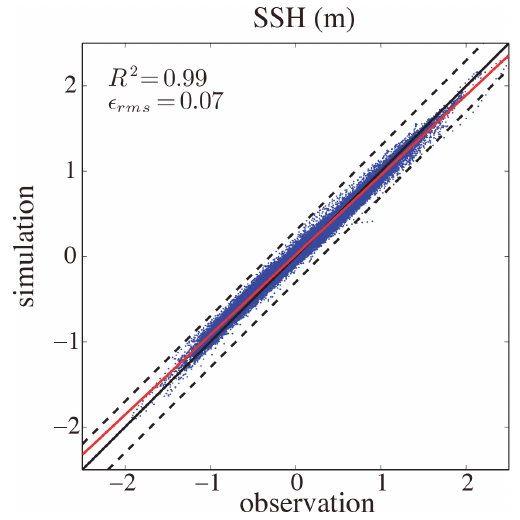
at station 8 (Kornwerderzand). The red line represents the lin- ear regression given by a coef + b coef × SSH observation . The cen- tre black line represents the ideal linear regression (simula- tion = observation), while the side dashed black lines are the ideal regression ± 0.3m. The coefficient of determination R 2 and the rms error (cid:15) rms are also